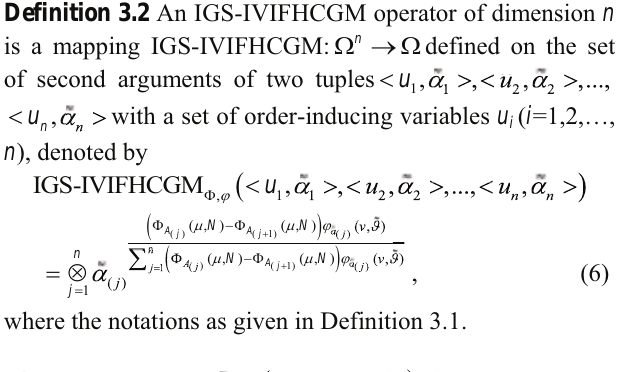
interval-valued intuitionistic fuzzy hybrid Choquet geometric mean (GS-IVIFHCGM)